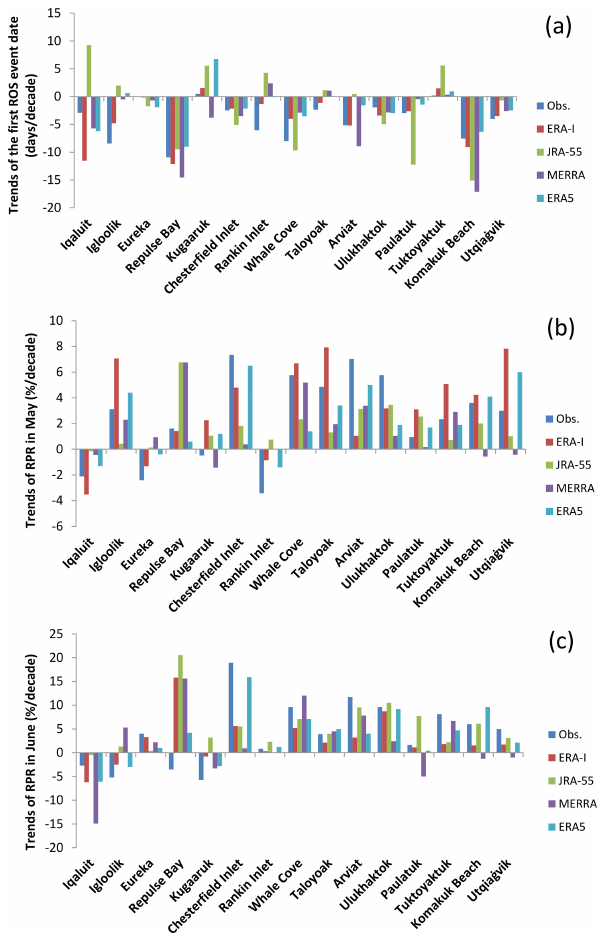
Figure 1. (a) Comparison of the trends in the first rain-on-snow (ROS) event date between the four reanalysis datasets and the sta- tion observations. (b) Comparison of trends in the rain–precipitation ratio (RPR) in May between different reanalysis datasets and the station observations. (c) Same as (b) but for June. The Utqia˙gvik station and 14 stations in the Canadian Arctic Archipelago (CAA; see Table 1 for station information) are used and arranged from east to